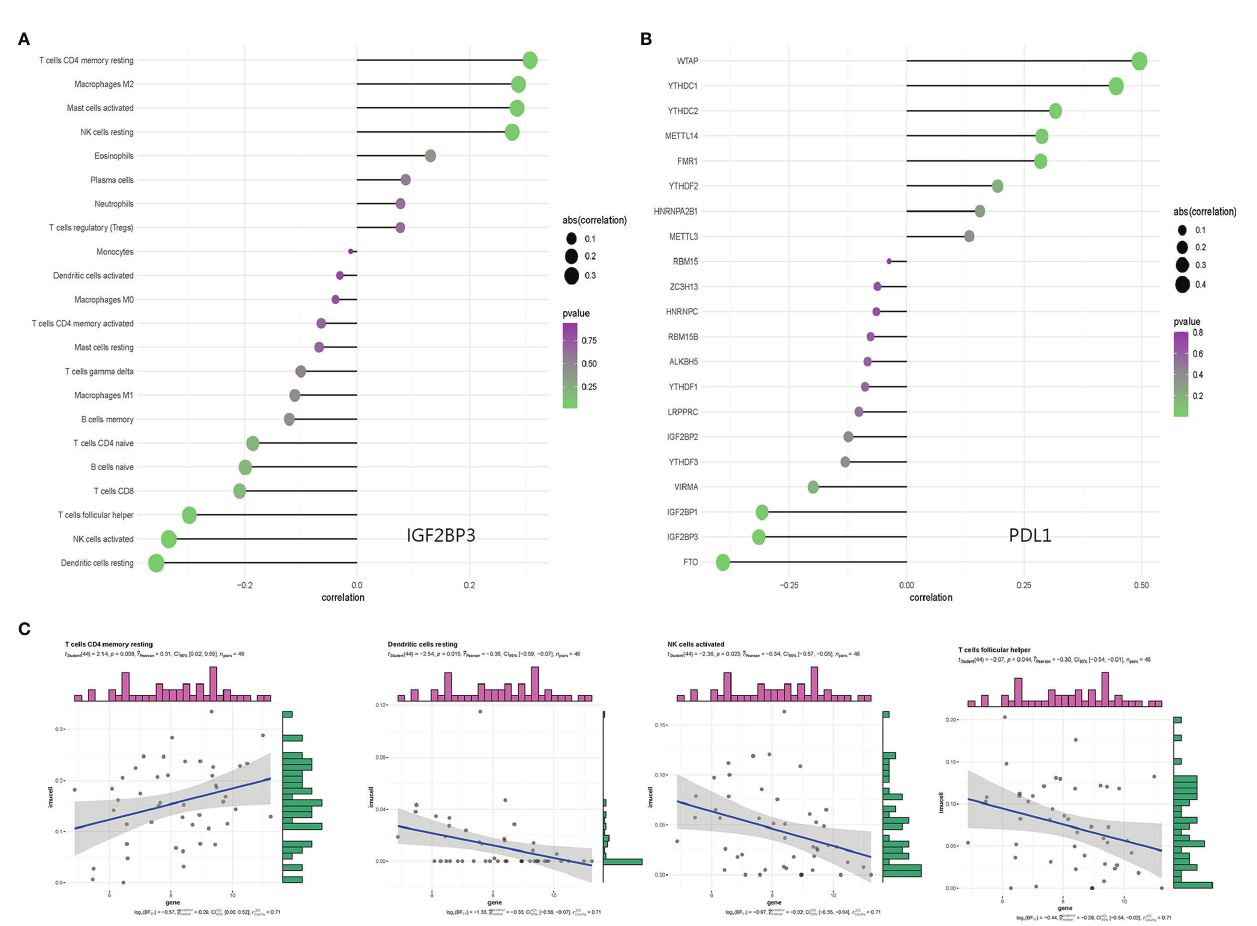
FIGURE 5 | (A) Bar graph of IGF2BP3 and immunocyte subtype content; (B) Correlation analysis between m6A related genes and PDL1; (C) Correlation results of IGF2BP3 with resting dendritic cells, activated NK cells, follicular helper T cells, and resting CD4+ memory T cell